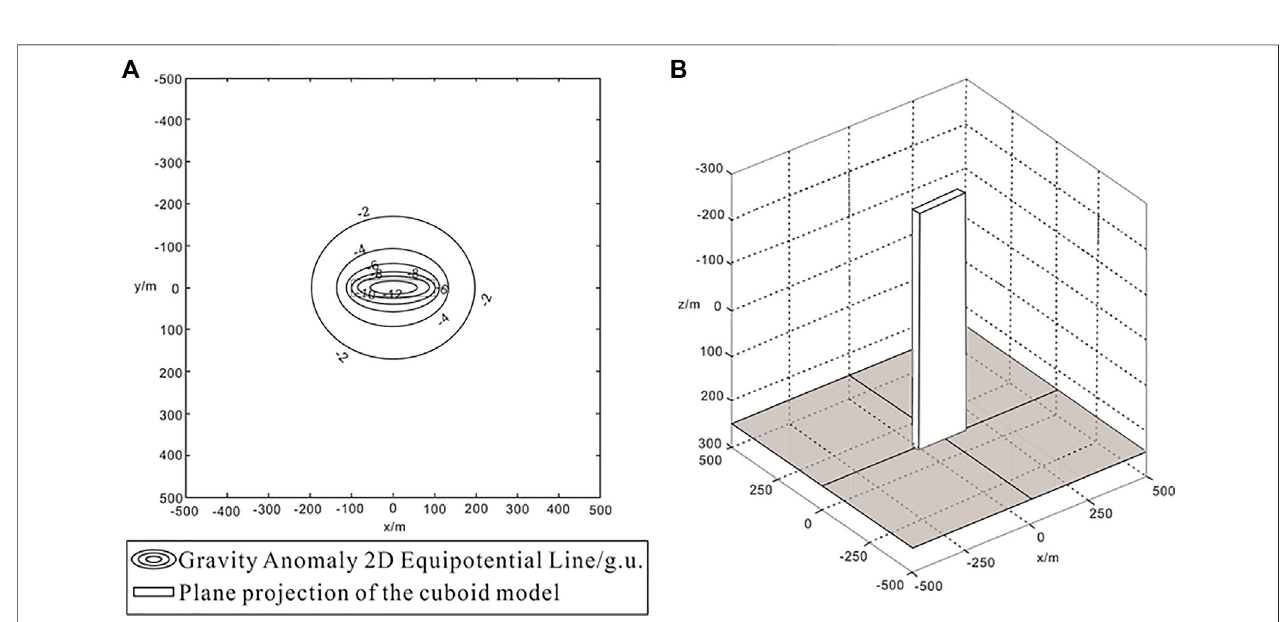
FIGURE 7 | Contour map of the gravity anomaly on the observation plane at z = 260